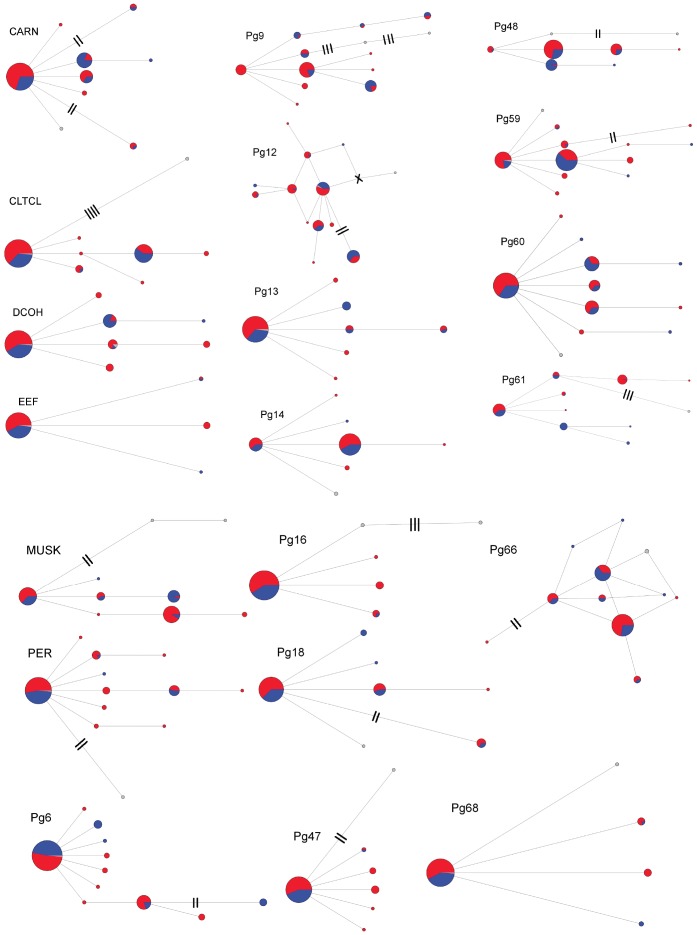
Haplotype networks.Median-joining haplotype networks for all 20 loci used in this study. Haplotypes are sized proportional to frequency (within each marker). Hash marks indicate haplotypes separated by two or more mutations. Blue and red indicate samples with western (pops. 1–3 in Fig. 2) or eastern (pops. 4–8) mtDNA haplotypes, respectively. Gray indicates outgroup samples. Points with an “X” through them (e.g. in Pg12) are inferred haplotypes that are absent in the sampling.